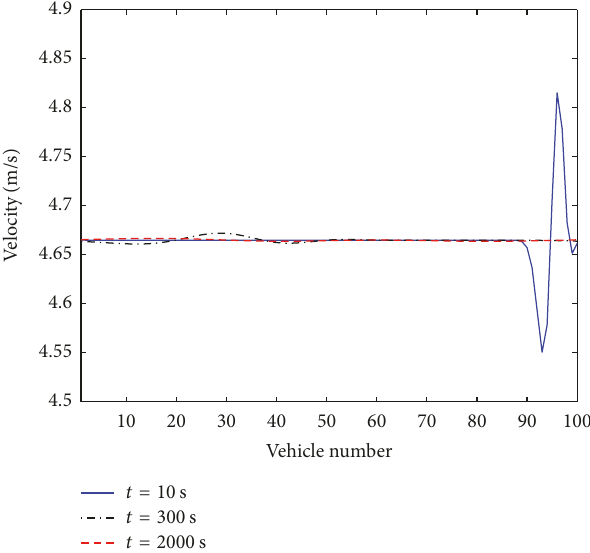
Figure 8: The snapshots of the velocity of all vehicles at different times for switched cooperative driving